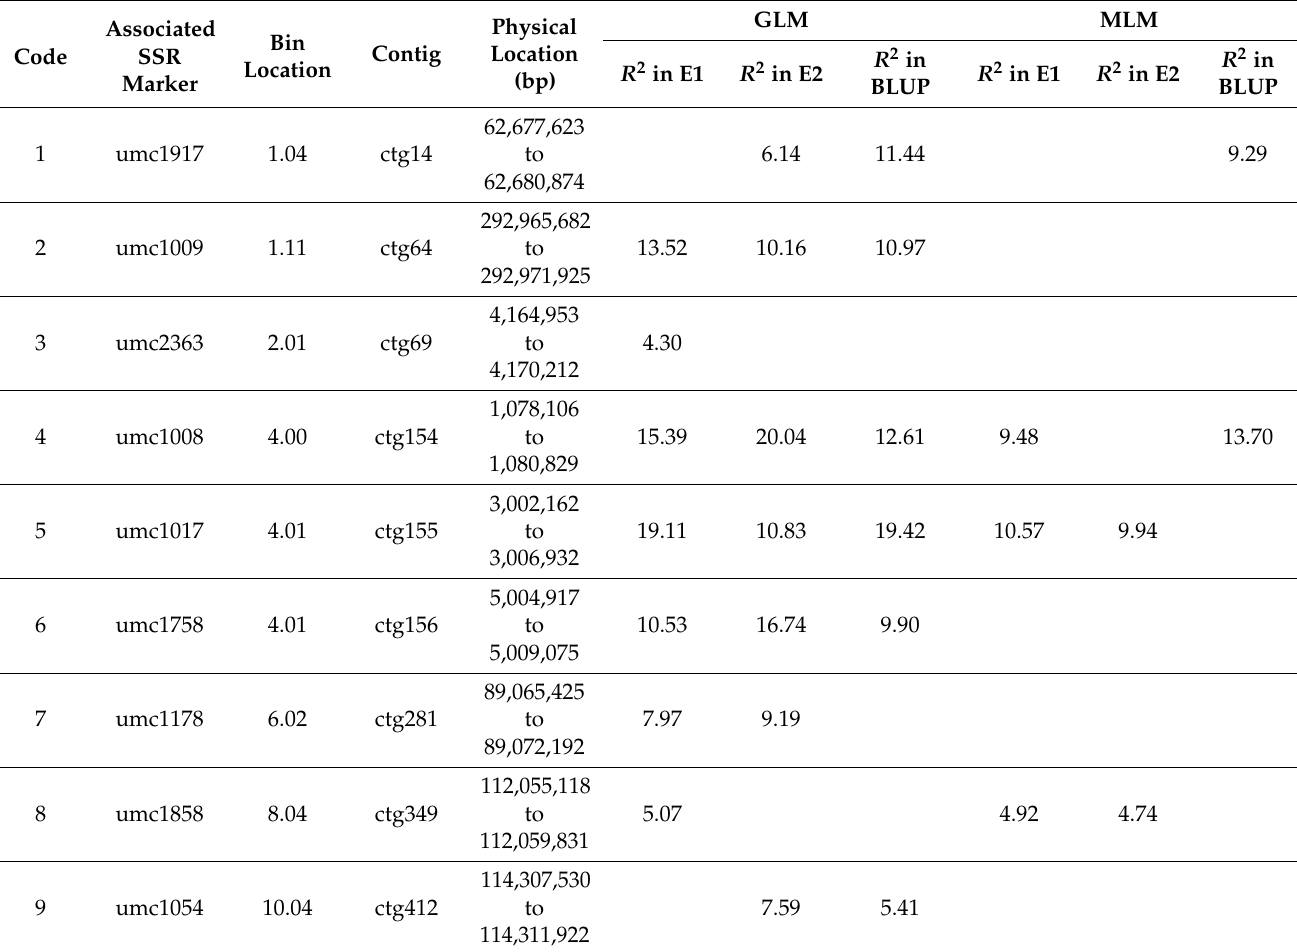
Table 1. SSR markers were found significantly ( p < 0.01) associated with DIMBOA content in both ecological environments, and their best linear unbiased prediction (BLUP) values in marker-trait association analysis were assessed using a general linear model (GLM) and mixed linear model (MLM), respectively.